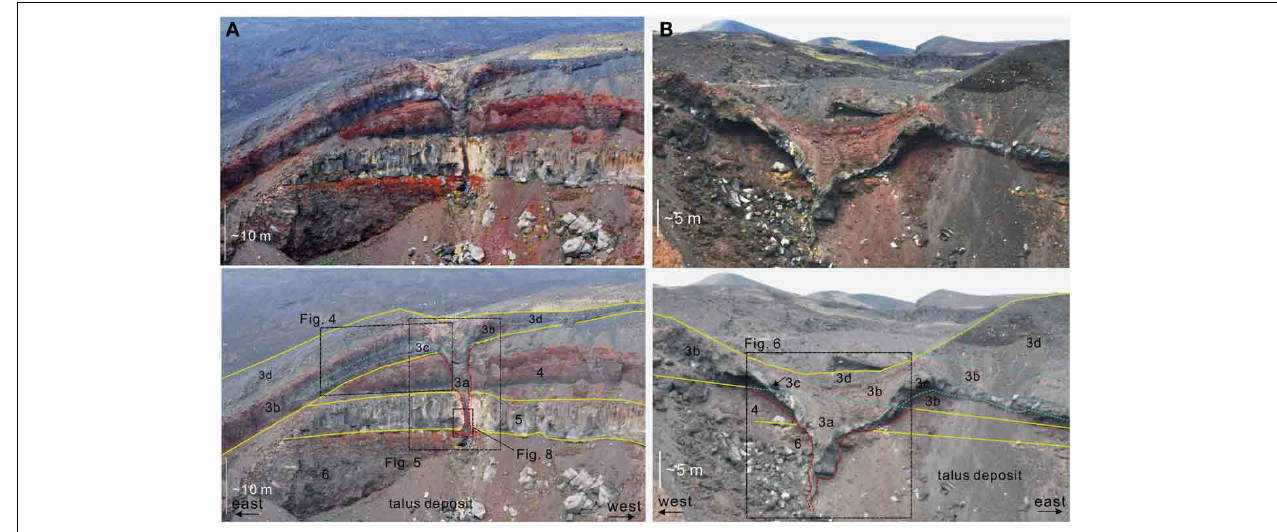
FIGURE 3 | Outcrops of the feeder system of the 1809 eruption along the walls of the crater A (see Figure 2 for location). (A) Southern wall (A–S); (B) northern wall (A–N). The two pictures at bottom illustrate the stratigraphic interpretation. The names of geological units are the